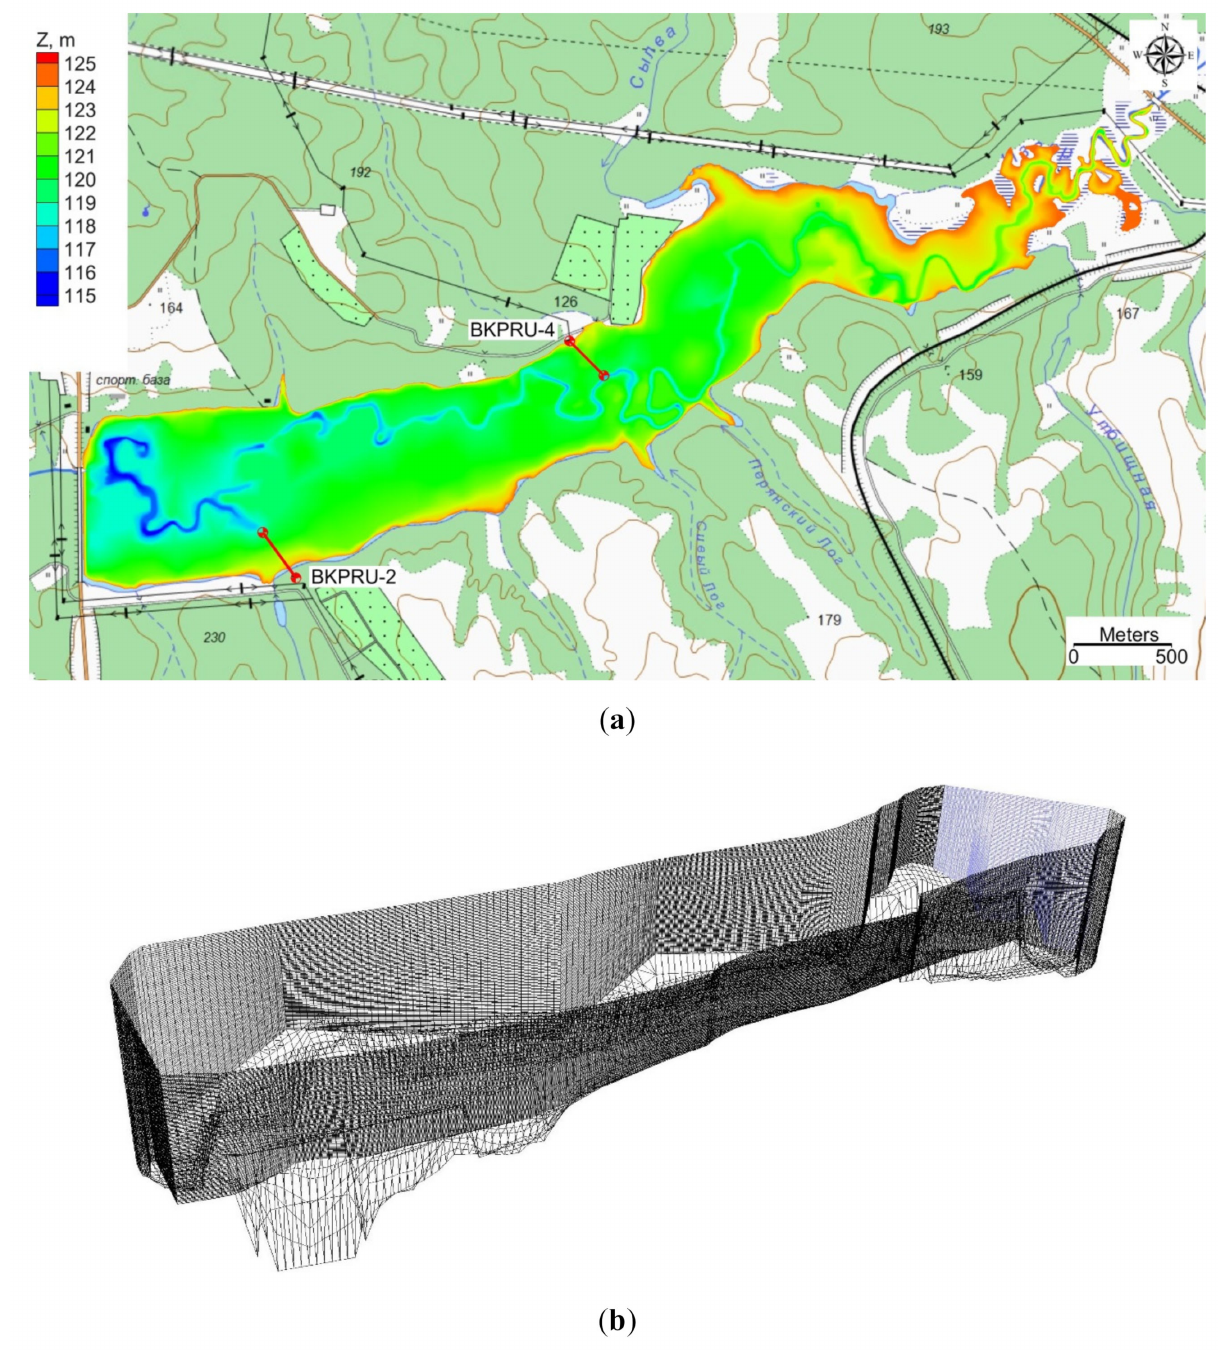
Figure 8. Section of modeling of the Verkhne-Zyryansk reservoir in a 3D formulation ( a ) and a computational grid ( b ). Section length was 3